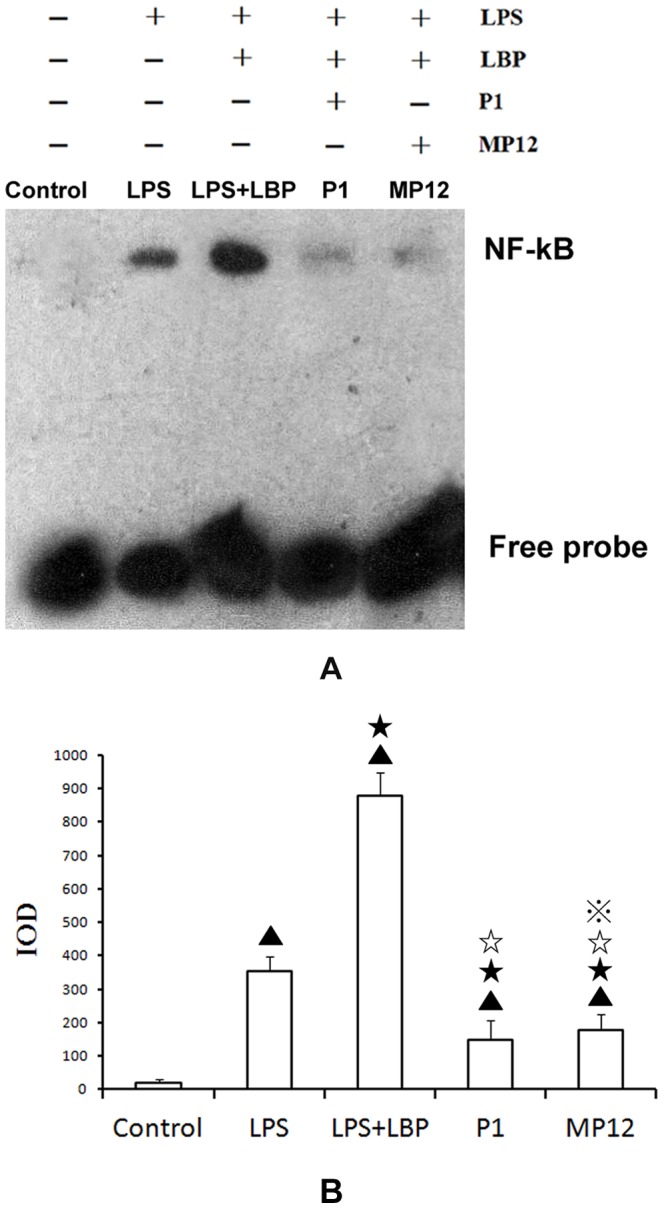
Effects of P1 and MP12 on NF-κB activity in U937 cells.A. NF-κB binding was significantly increased by LPS treatment. After treatment with P1 or MP12, NF-κB binding decreased; a more significant decrease was found with P1 treatment compared to MP12 treatment. B. IOD values were obtained using TotalLab Quant software. ▴ compared with the control: P<0.01; ★ compared with LPS treatment: P<0.01; ☆compared with LPS+LBP group: P<0.01;  compared with P1 group: P<0.05.